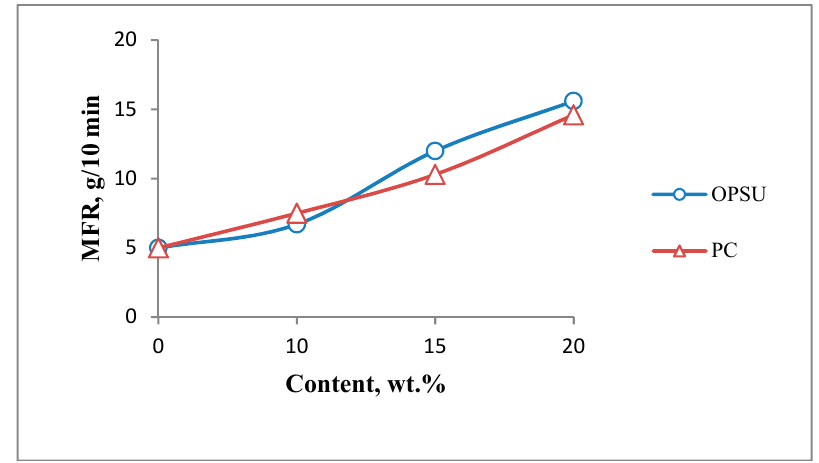
Figure 6. MFR PEI-carbon fibers (CF) with different content of OPSU and PC.